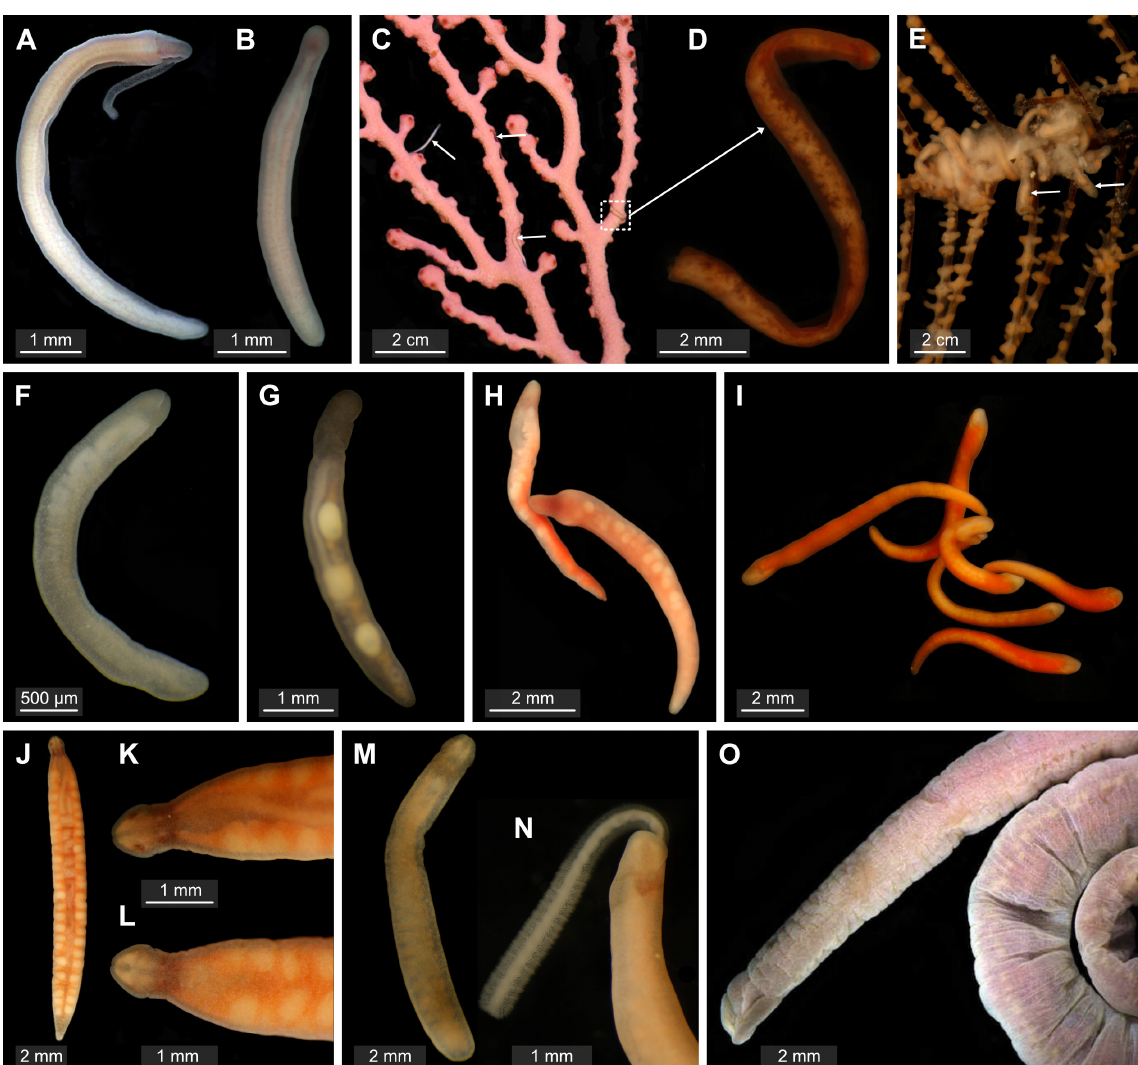
Fig. 8. Live images of eumonostiliferous hoplonemerteans collected along the Costa Rica margin and the NE Pacific. A . Chernyshevia escarpiaphila sp. nov., paratype (SIO-BIC N112). B . Chernyshevia escarpiaphila sp. nov., paratype (SIO-BIC N266). C . Octocoral Paragorgia sp. (SIO-BIC Co3054) with several specimens of Alvinonemertes dariae sp. nov., holotype (arrows; ex SIO-BIC N262). D . Alvinonemertes dariae sp. nov., holotype (ex SIO-BIC N262). E . Antipatharian coral (SIO-BIC Co3031) with specimens of Alvinonemertes dagmarae sp. nov., holotype (SIO-BIC N260). F . Alvinonemertes christianeae sp. nov., holotype (SIO-BIC N253). G . Alvinonemertes claudiae sp. nov., holotype (ex SIO-BIC N231). H . Alvinonemertes tatjanae sp. nov., holotype (SIO-BIC N119). I . Eumonostilifera (SIO-BIC N259). J–L . Tetrastemma sundbergi sp. nov., holotype (SIO-BIC N256) whole animal (J), dorsal view of head (K), and ventral view of head (L). M . Tetrastemma polyakovae sp. nov. (MZUCR Nemertea Collection MZUCR-101-01). N . Tetrastemma polyakovae sp. nov., holotype (SIO-BIC N258), with everted proboscis. O . Eumonostilifera (SIO-BIC